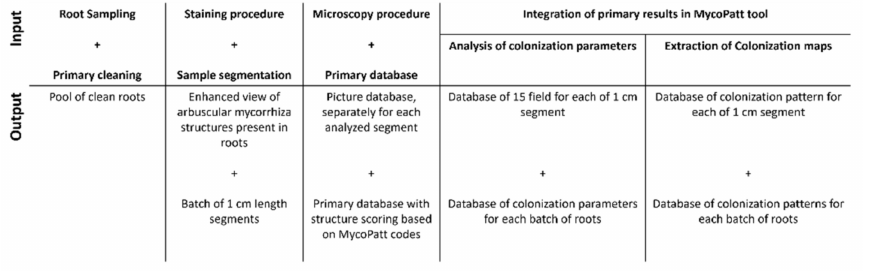
Figure 7. Flowchart of mycorrhizal quantification in the roots of Festuca rubra , based on MycoPatt